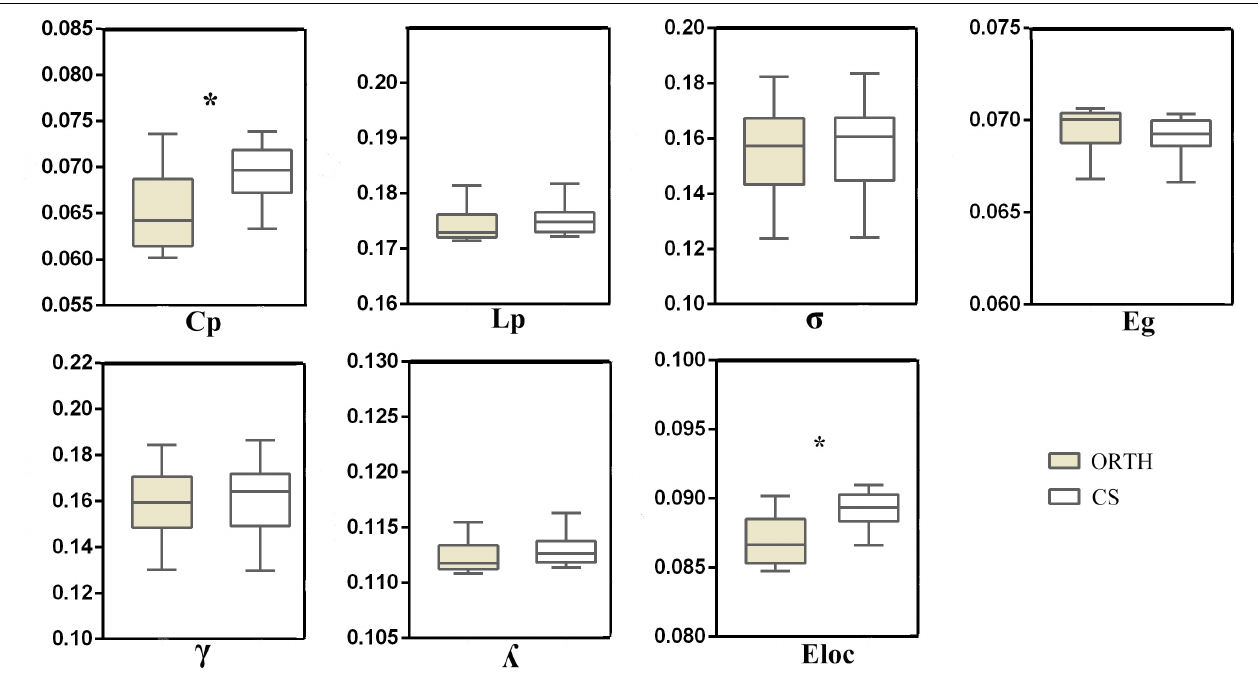
FIGURE 2 | The topological properties of brain functional networks in orthodontic pain subjects (ORTH) and control subjects (CS), shown as the area under the curve across the sparsity range. Significant between-group differences were found in C p ( t = –5.43, p < 0.001) and E loc ( t = –6.62, p < 0.001). Abbreviations: C p , clustering coefficient; L p , characteristic path length; γ , normalized clustering coefficient; λ , normalized characteristic path length; σ , small-worldness; E loc , local efficiency; E g , globe